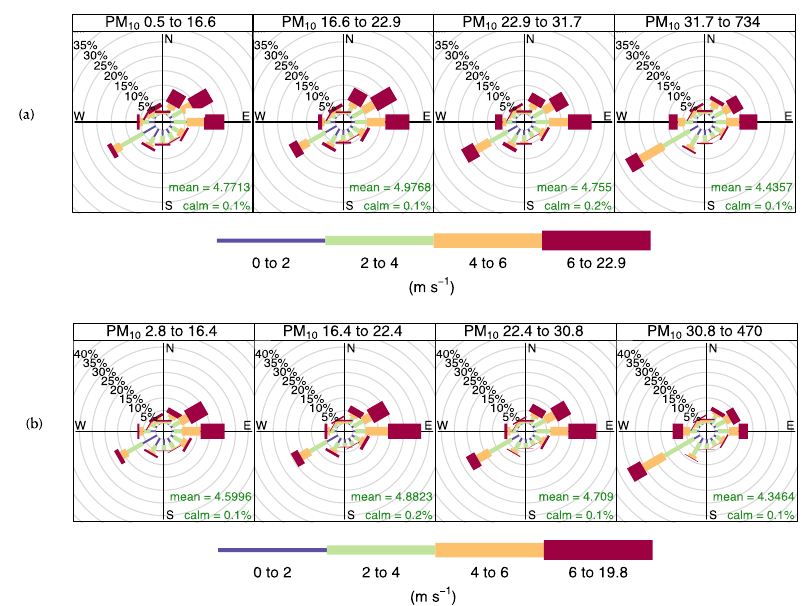
Figure 2. Persistence of PM 10 observations by wind direction (%) at Sile station: ( a ) pre-lockdown period; ( b ) during-lockdown period.